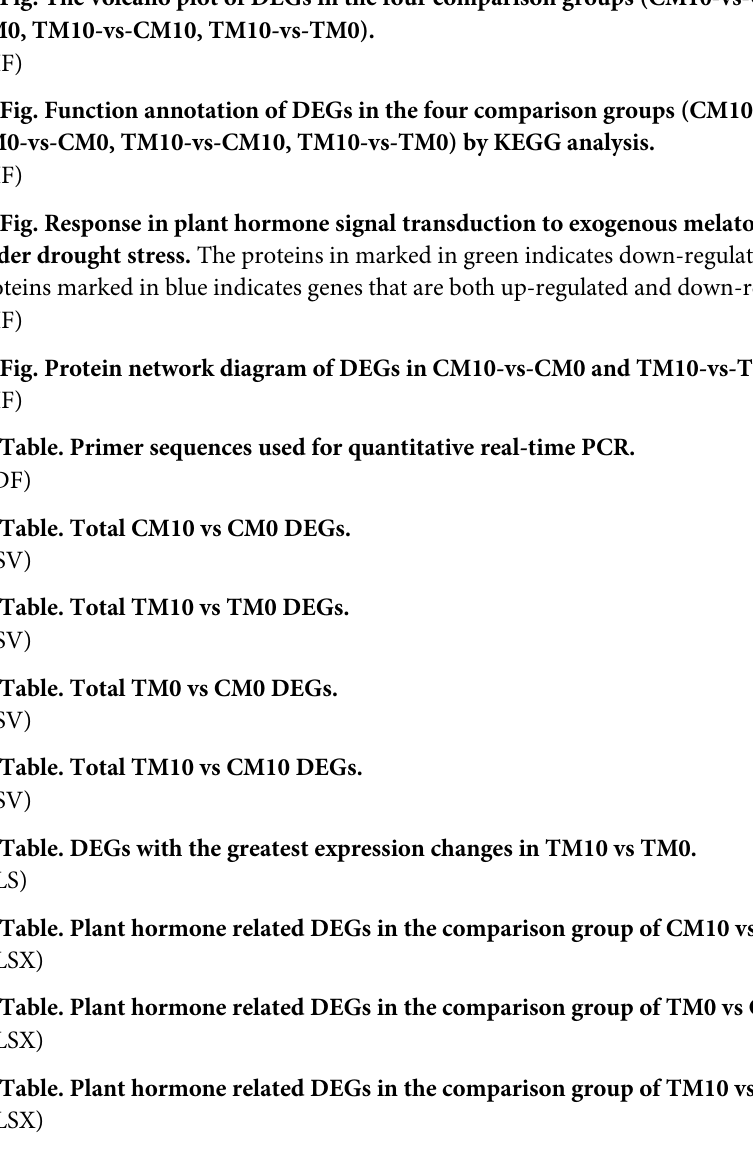
S1 Fig. Flow chart of RNA-Seq analysis. (TIF) S2 Fig. The volcano plot of DEGs in the four comparison groups (CM10-vs-CM0, TM0-vs- CM0, TM10-vs-CM10, TM10-vs-TM0). (TIF) S3 Fig. Function annotation of DEGs in the four comparison groups (CM10-vs-CM0, TM0-vs-CM0, TM10-vs-CM10, TM10-vs-TM0) by KEGG analysis. (TIF) S4 Fig. Response in plant hormone signal transduction to exogenous melatonin treatment under drought stress. The proteins in marked in green indicates down-regulated genes, the proteins marked in blue indicates genes that are both up-regulated and down-regulated. (TIF) S5 Fig. Protein network diagram of DEGs in CM10-vs-CM0 and TM10-vs-TM0. (TIF) S1 Table. Primer sequences used for quantitative real-time PCR. (PDF) S2 Table. Total CM10 vs CM0 DEGs. (CSV) S3 Table. Total TM10 vs TM0 DEGs. (CSV) S4 Table. Total TM0 vs CM0 DEGs. (CSV) S5 Table. Total TM10 vs CM10 DEGs. (CSV) S6 Table. DEGs with the greatest expression changes in TM10 vs TM0. (XLS) S7 Table. Plant hormone related DEGs in the comparison group of CM10 vs CM0. (XLSX) S8 Table. Plant hormone related DEGs in the comparison group of TM0 vs CM0. (XLSX) S9 Table. Plant hormone related DEGs in the comparison group of TM10 vs CM10.